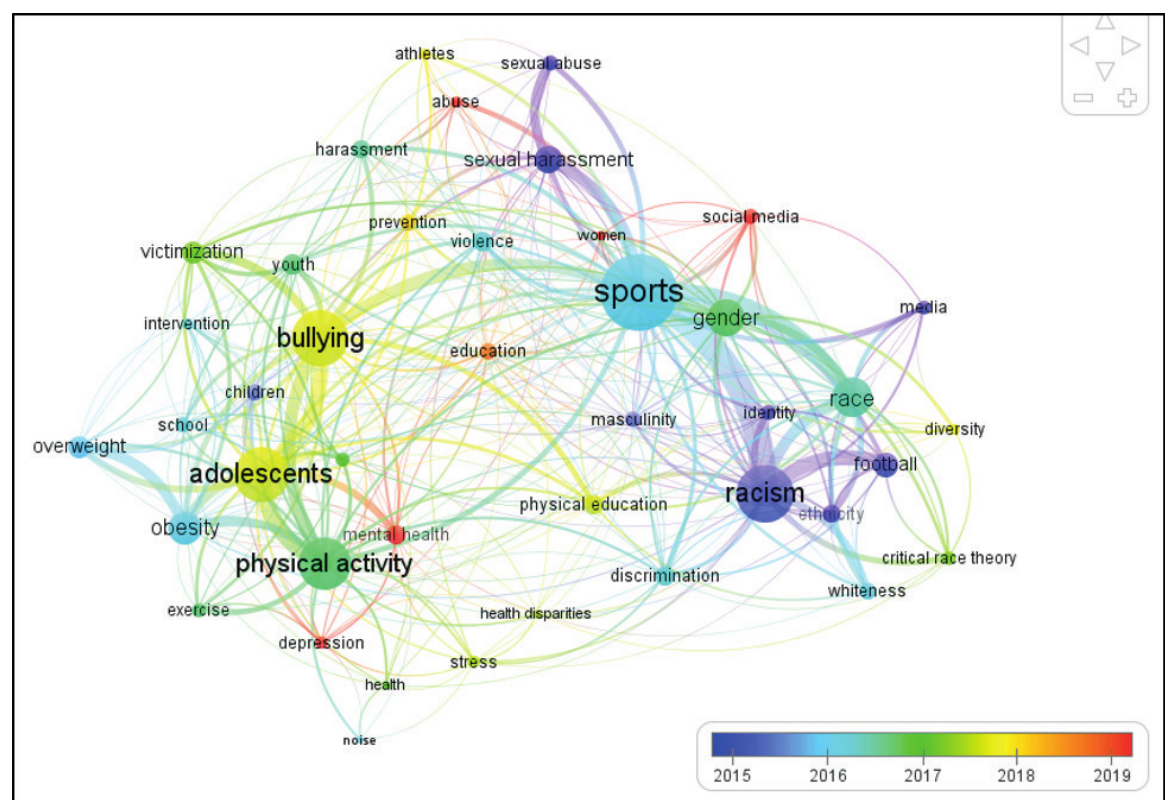
Figure 5. Overlay visualisation of the co-occurrence of authors’